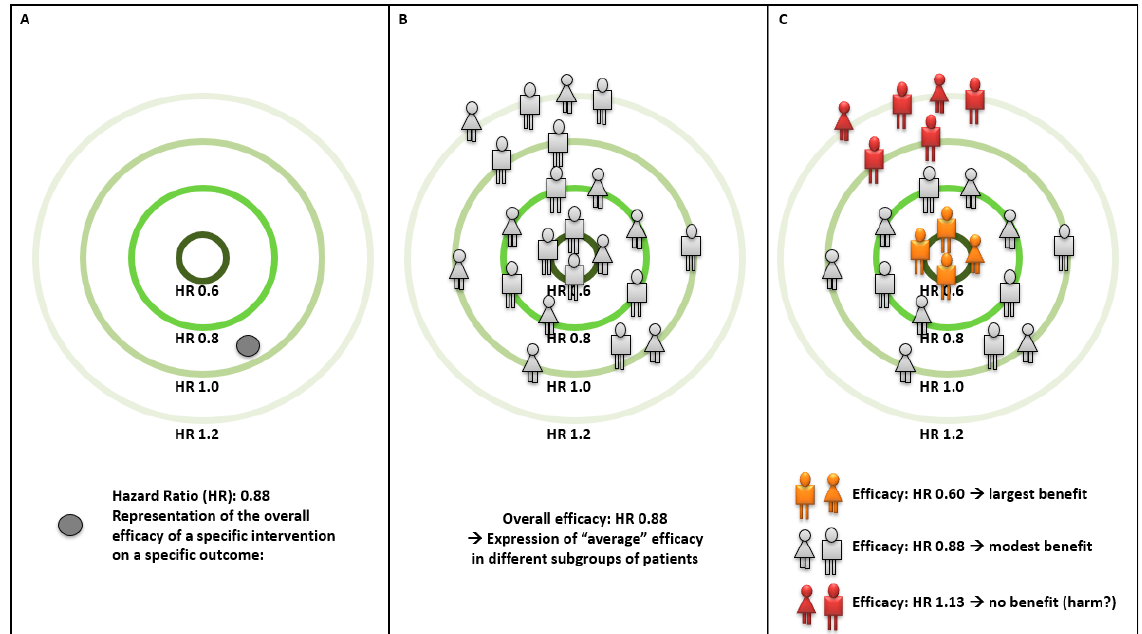
Figure 1. Graphical representation of precision medicine approaches improving clinical benefit of an inter-vention (overall described in panel ( A )) through identification of subgroups of subjects (overall de-scribed in Panel ( B )) with a larger relative benefit (i.e., smaller hazard ratio) from that treatment (depicted in panel ( C